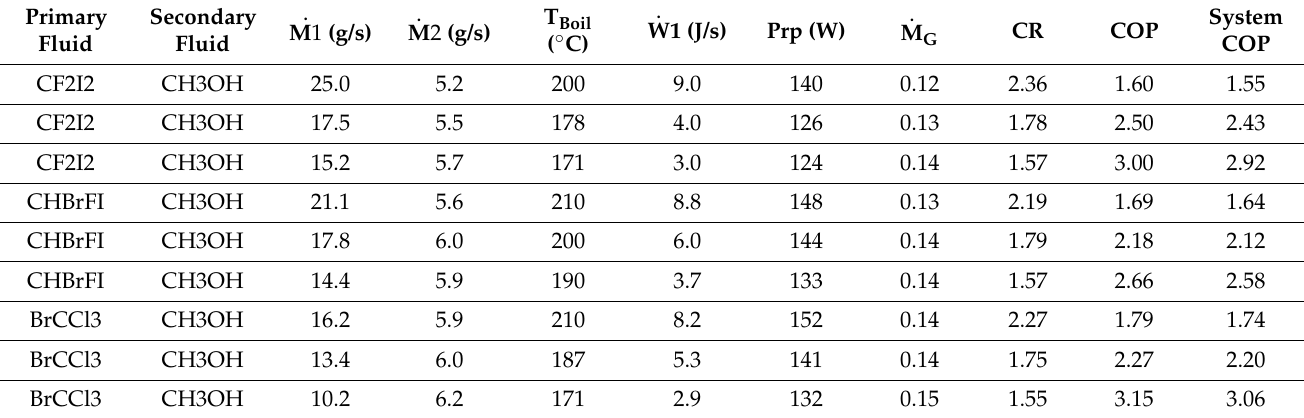
Table 4. System COP estimation of the BFE GSHP cooling